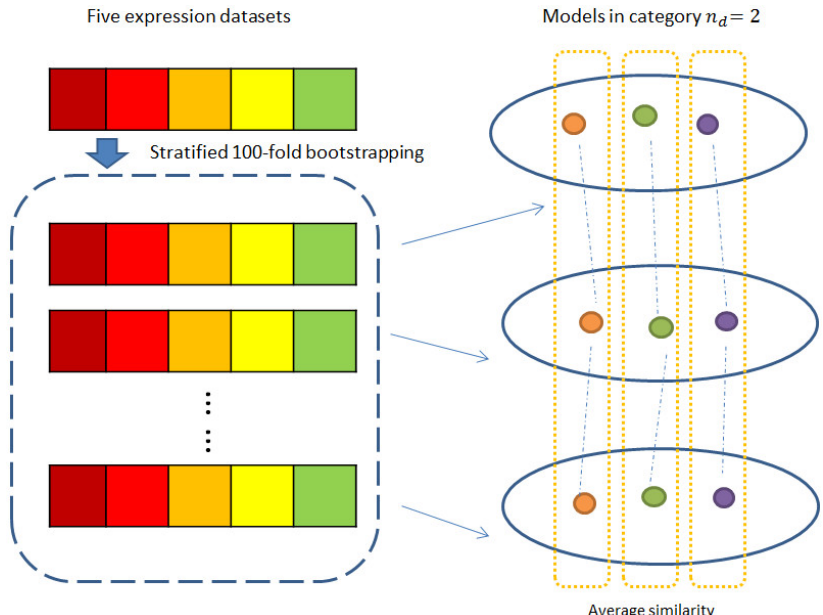
Figure A3. Illustration of model stability calculation. Stability quantified the robustness of an algorithm against sampling variability. This metric was computed by performing 100-fold-stratified-bootstrapping. In the left panel, five expression datasets are shown as colored boxes. Using n d = 2 as an example, two out of five datasets were combined for training in each bootstrapping sample. Thus, a series of models were obtained as illustrated as the colored circles in the right panel. The stability was determined as the average pairwise similarity for each model, calculated across all pairs of bootstrapping samples.